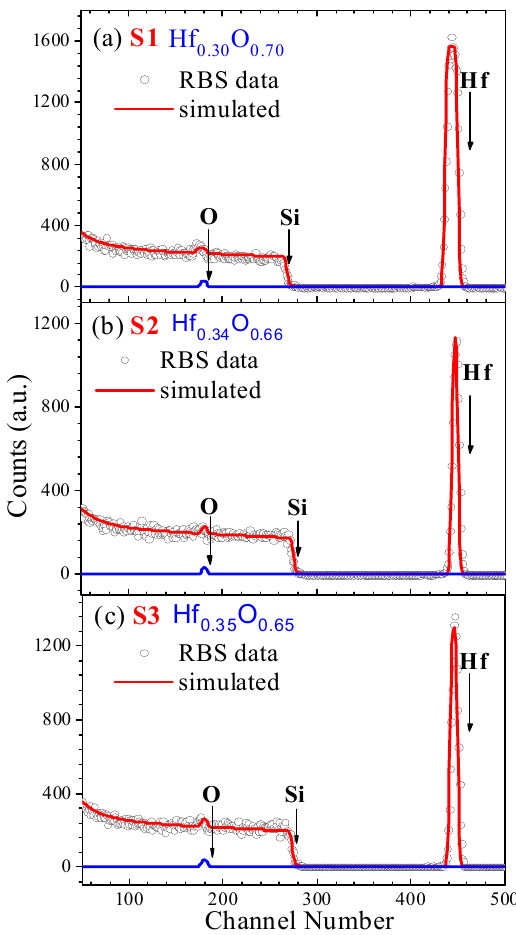
Figure 5. Random (open circles) and simulated fitting (solid lines) RBS spectra of of S1, S2 and S3 are shown in ( a – c ), respectively.